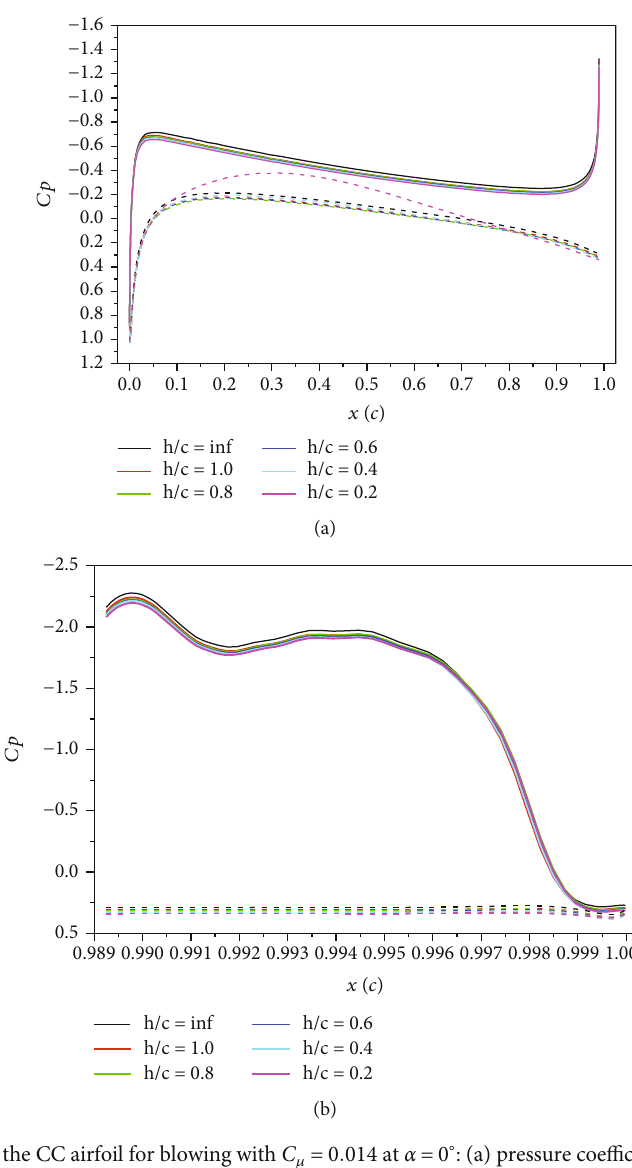
Figure 19: Pressure coe ffi cient of the CC airfoil for blowing with C coe ffi cient of the Coanda